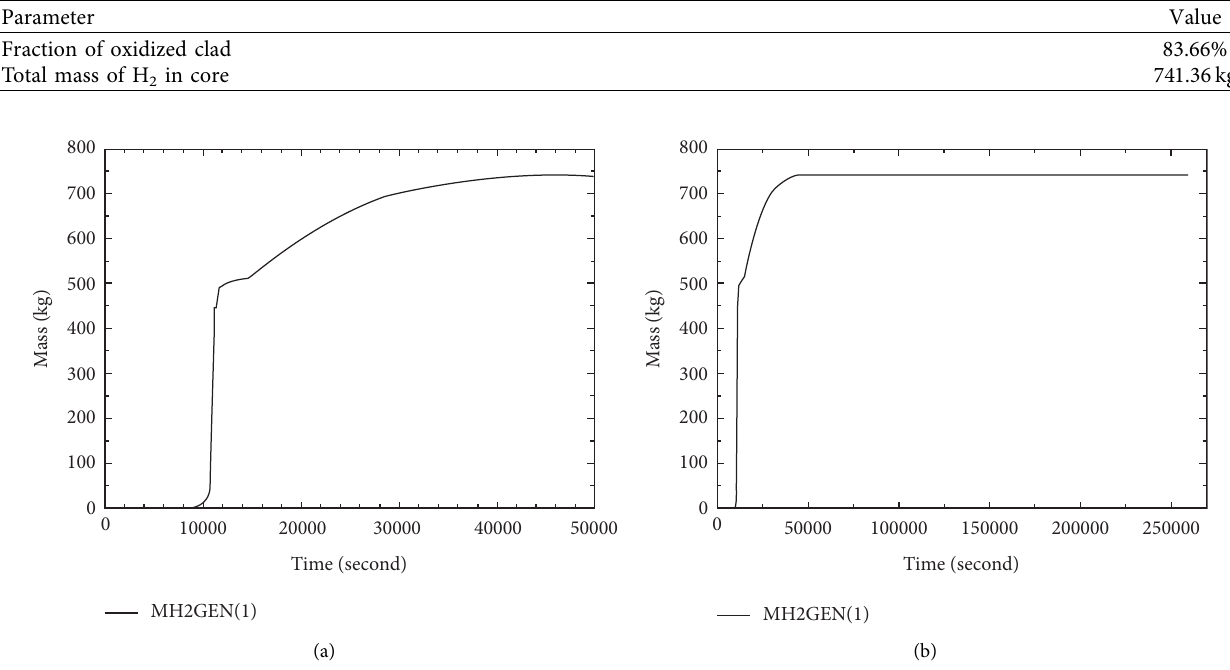
Table 8: Key figures of merits without PAR activation.